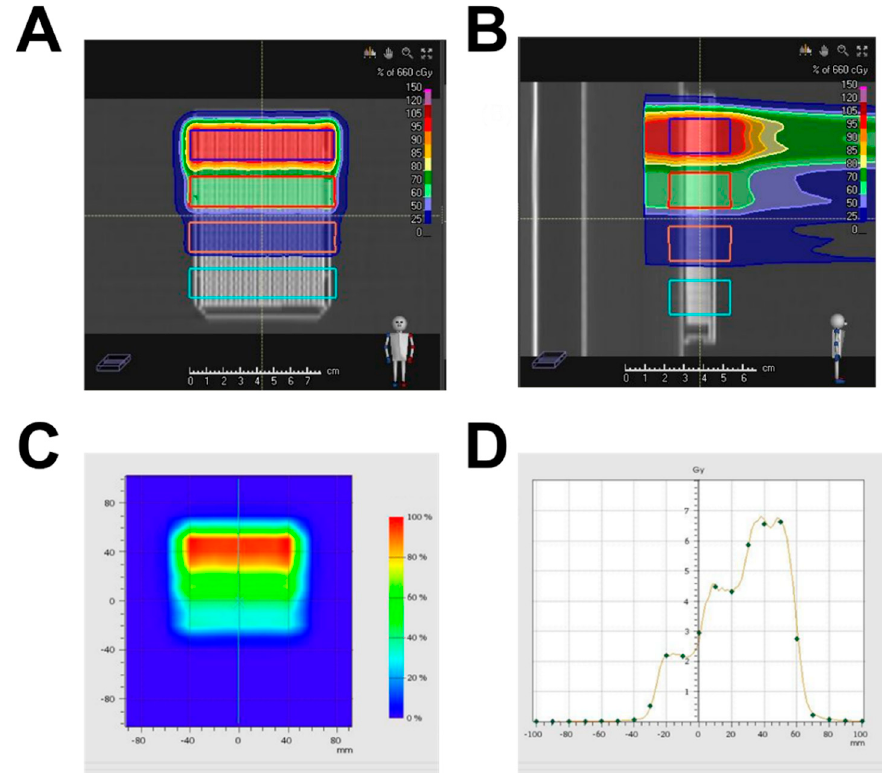
Figure 2. Dose distribution of the 4-step cell irradiation plan. Homogeneous dose distributions were achieved by each plateau, and delivered doses decreased in a stepwise manner. ( A ) Coronal view; ( B ) sagittal view. ( C ) Delivered doses were measured by 2D ion chamber array. ( D ) One-dimensional dose distribution of plan and measurement were plotted. The measured dose points were spaced at 1 cm intervals, and are denoted as dots. The solid line indicates the plan dose.